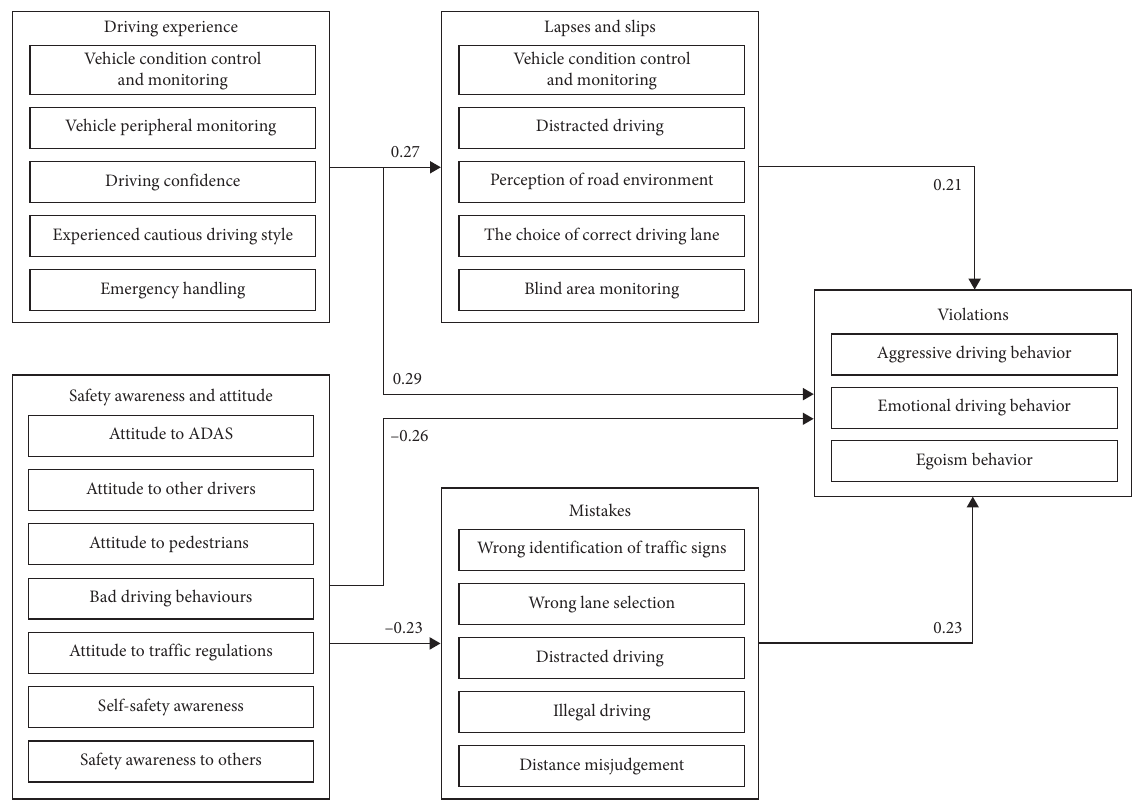
Figure 5: Schematic diagram of driving behaviour and its influencing